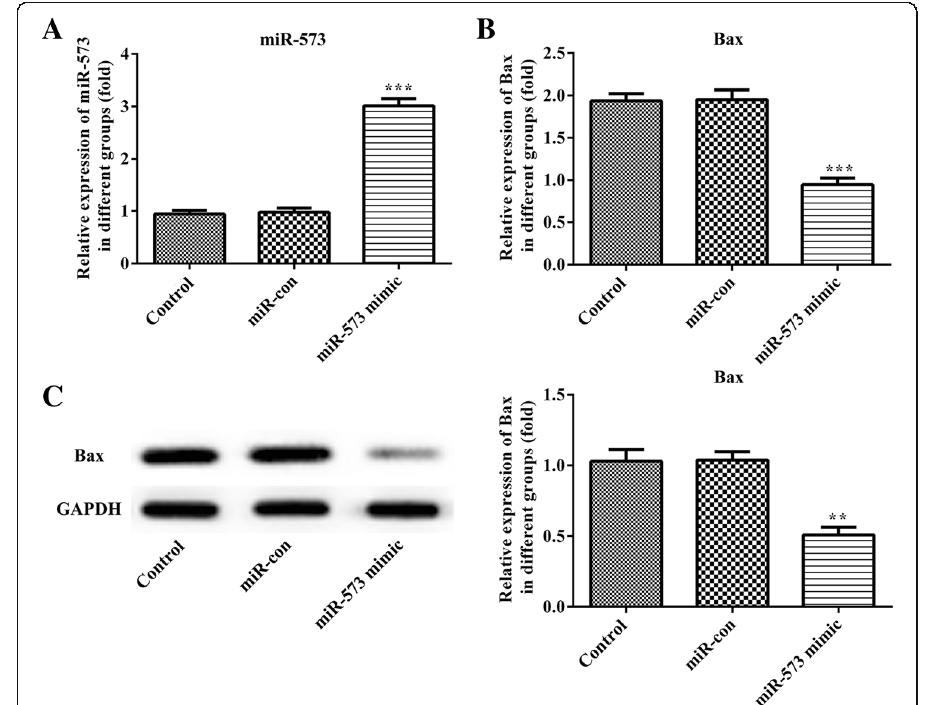
Fig. 2 Expression levels of miR-573 and Bax in degenerative NP cells. Cells were transfected with miR-573 mimic, or mimic control for 48h. Relative expression levels of miR-573 ( a ) and Bax ( b ) were measured by qRT- PCR. c Protein expression levels of Bax were measured by Western blot. ** P <0.01, *** P <0.001 versus